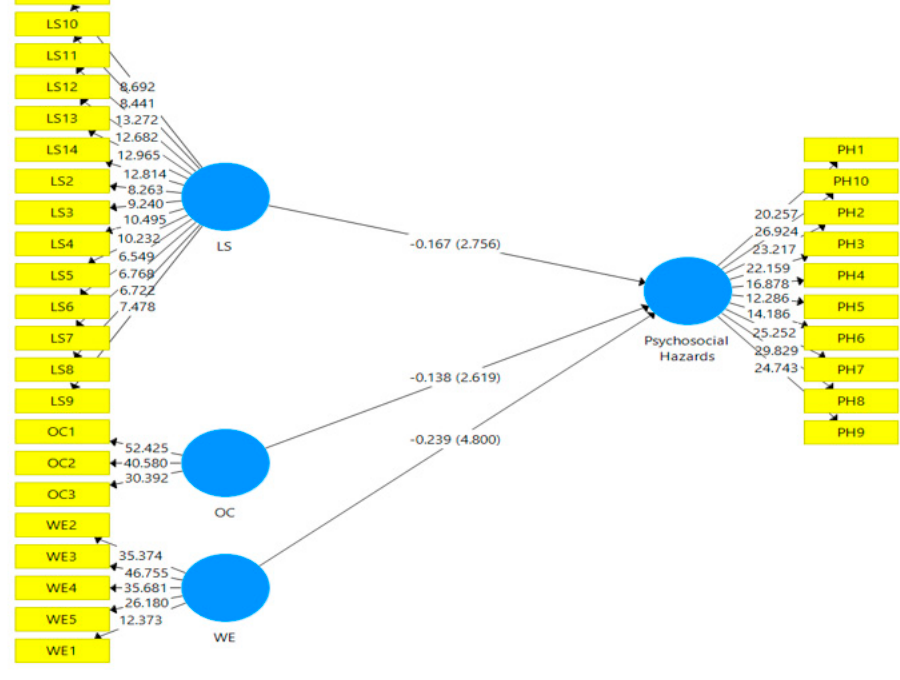
Figure 3. Bootstrapping analysis and T-values.